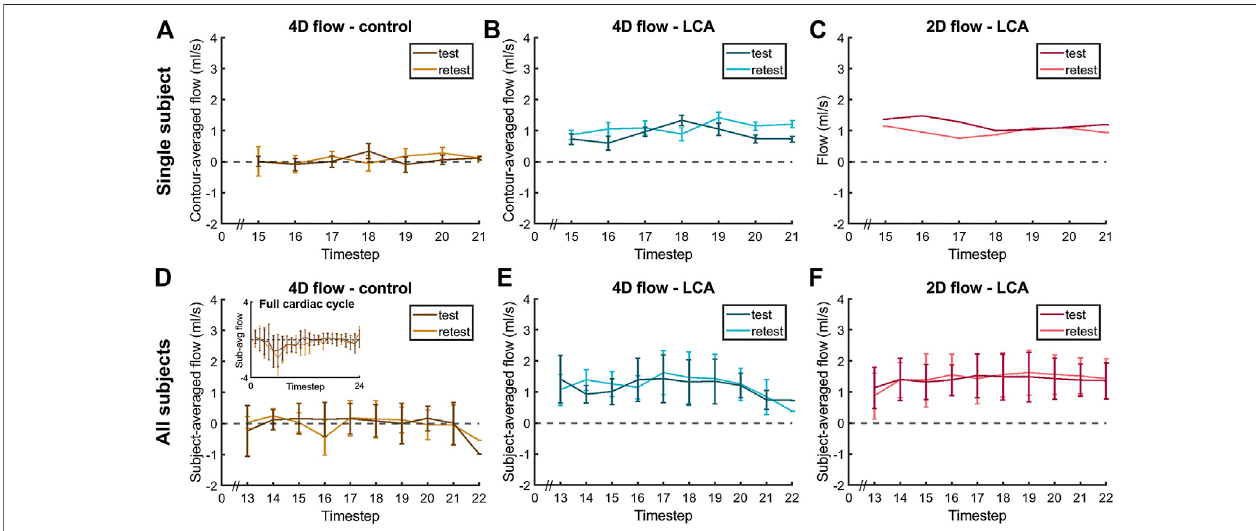
FIGURE 5 | Diastolic fl ow measured by 4D fl ow MRI and 2D fl ow MRI in the LCA and by 4D fl ow MRI in the adjacent pericardial fat ( “ 4D fl ow - control ” ) in a single subject (A – C) ,samesubjectasin Figure4 )andaveragedoverallsubjects (D – F) ,displayedforscanandrescan4D fl owMRIacquisitions.Single-subject fl owcurvesare the result of averaging over all fi ve measurement contours. All-subjects fl ow curves are the average over all eleven subject-speci fi c (contour-averaged) fl ow